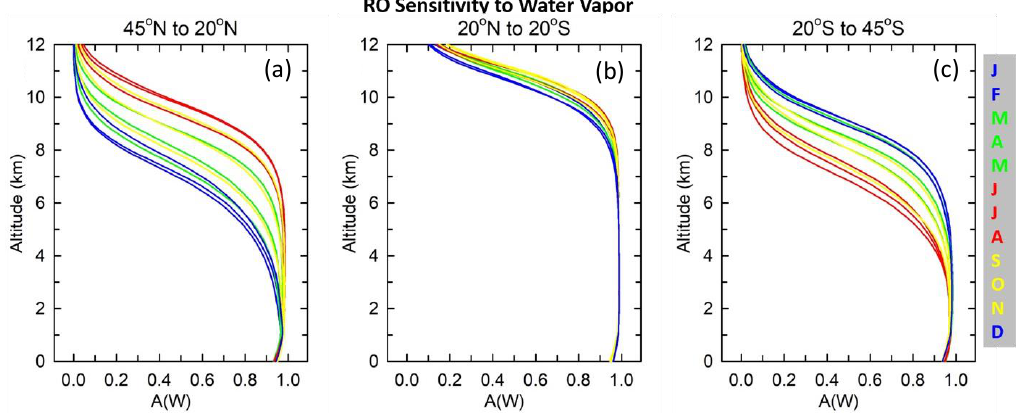
Figure 7. The same as Figure 6 but for RO sensitivity to the water vapor.